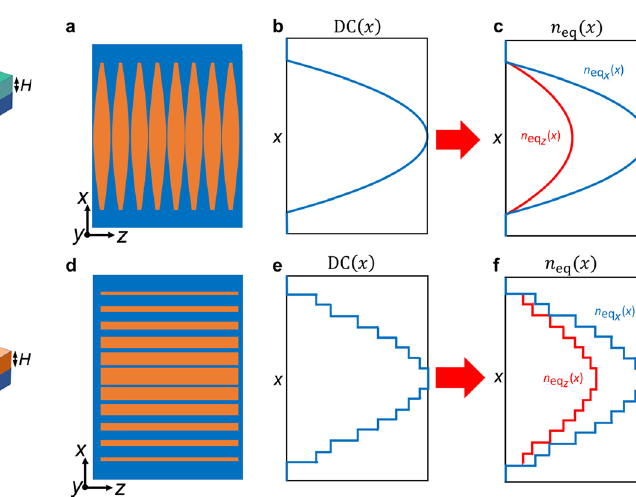
Figure 5: (a) Subwavelength grating slab with periodic core of period Λ and silicon thickness H = 220 nm. (b) Effective index of the fundamental TE slab mode propagating along the z -axis ( n eff ). (c) Mapping function between the effective index of the x -axis ( n eff z fundamental TE mode of an isotropic slab and the corresponding core material refractive index. (d) Synthesized refractive index tensor components for a periodic-core slab with period Λ .